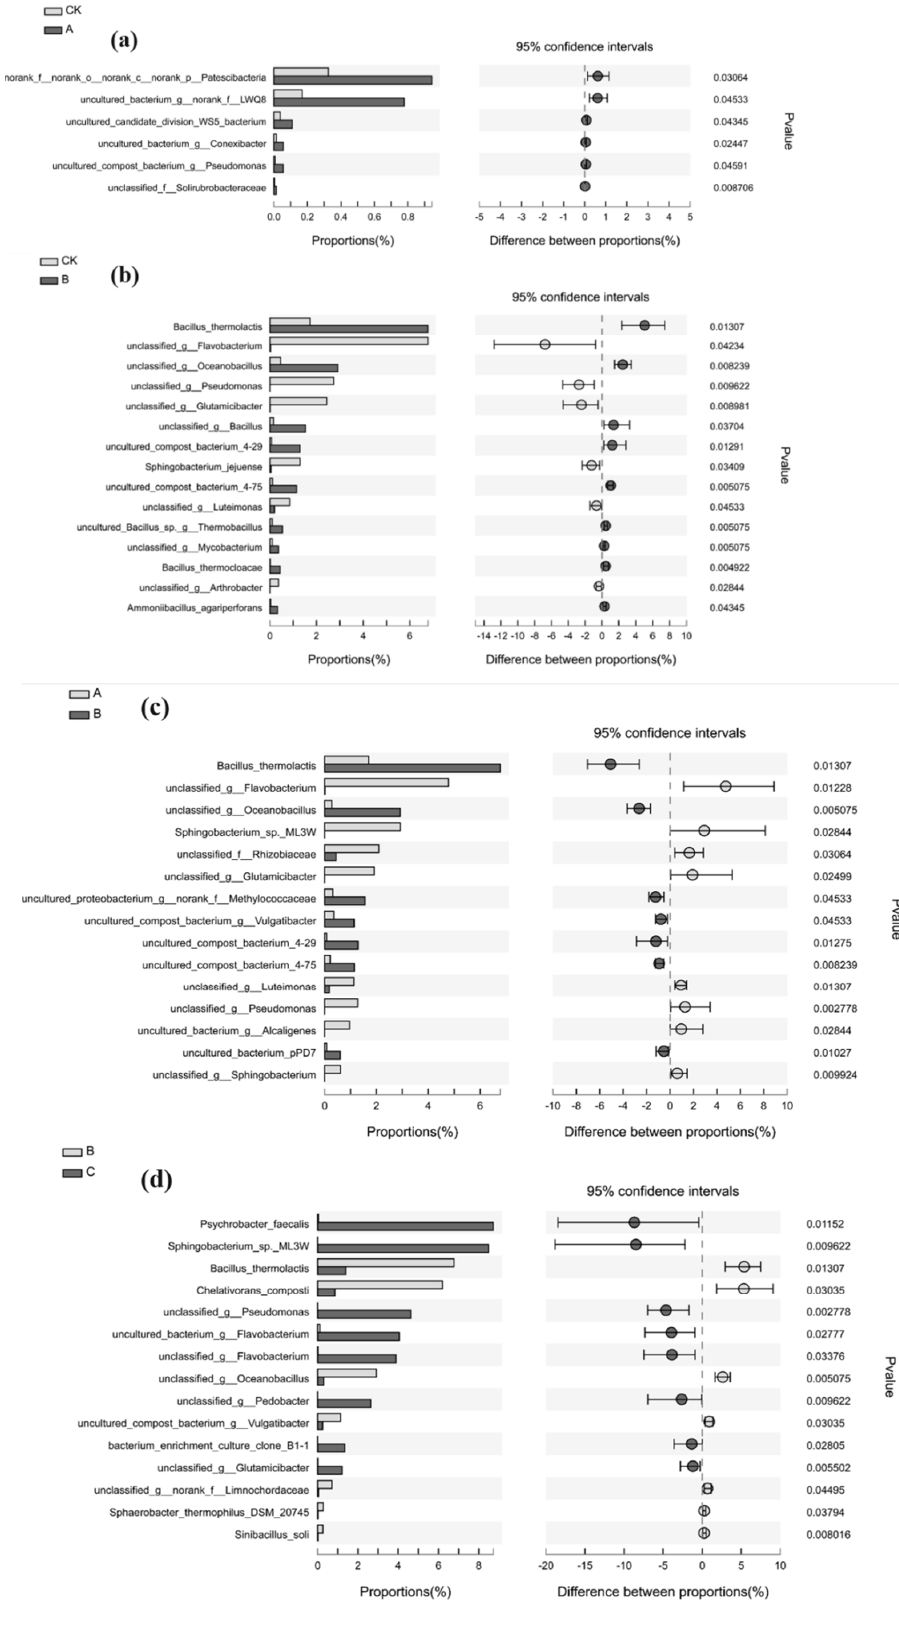
Figure 6. Differences in bacteria at the species level: CK vs. A ( a ), CK vs. B ( b ), A vs. B ( c ), and B vs. C ( d ).